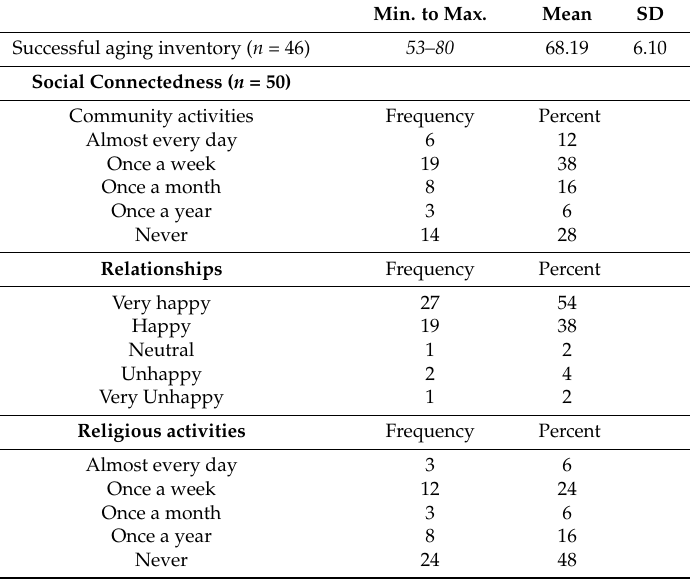
Table 2. Summary of social determinants of health in the regression analysis. Min. to